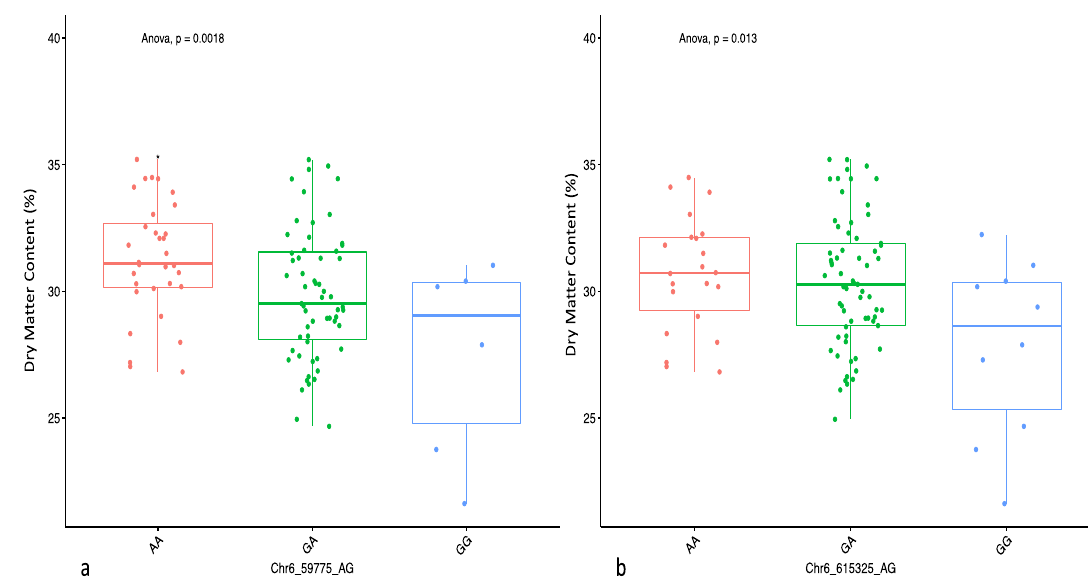
Figure 3. Boxplots showing the effect of the significant markers associated with tuber DMC on chromosome 6 with two SNPs: ( a ) Chr6_59775 and ( b ) Chr6_615325. The letters on the X axis represent allele variants (AA, GA, and GG); significant codes: * = 0.05 and p represents the analysis of variance probability value associated with the variation across variants.